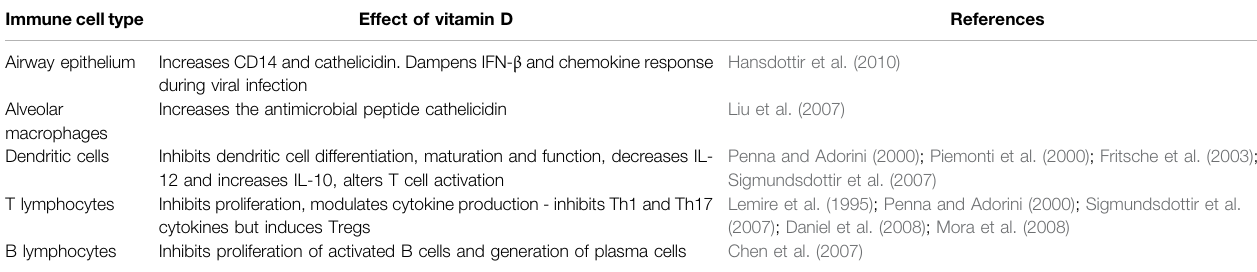
TABLE 1 | Some effects of vitamin D on the immune